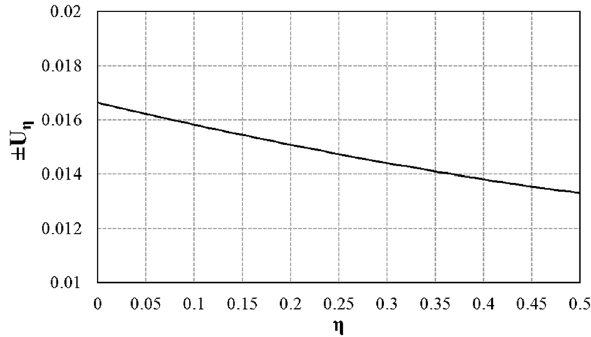
Fig. 13 Uncertainty of η as a function of its